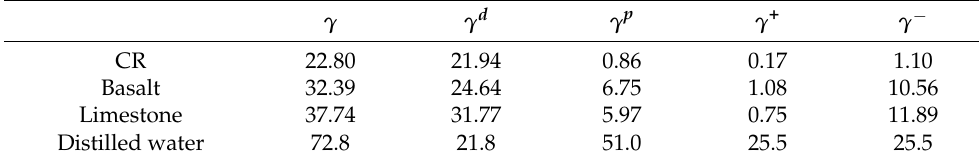
Table 11. Surface free energy parameters of different materials (mJ/m 2